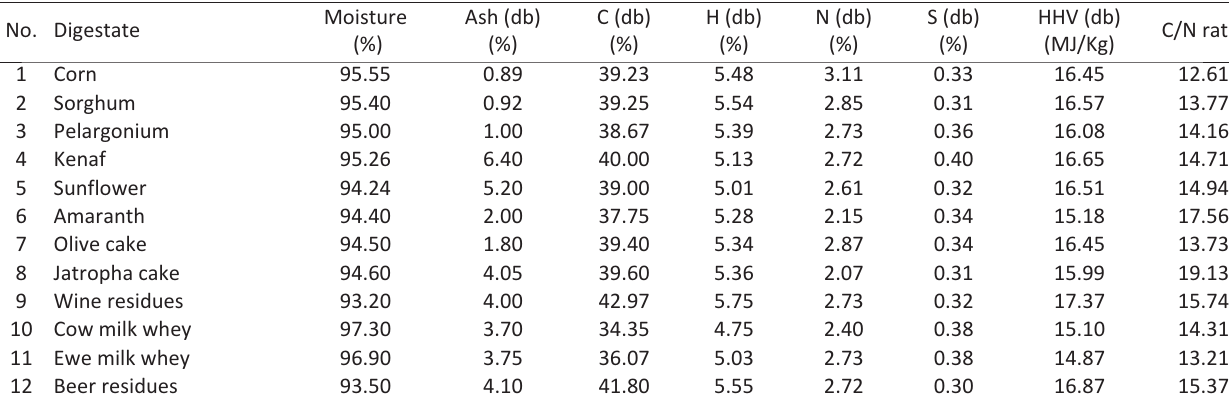
Table 6 - Digestate elemental